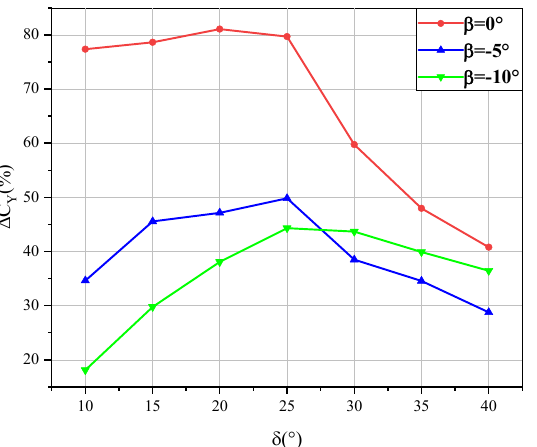
Figure 15. Lateral force increment of vertical tail model under different sideslip angles (C μ = 0.332%, Re = 2.12 × 10 5 ).